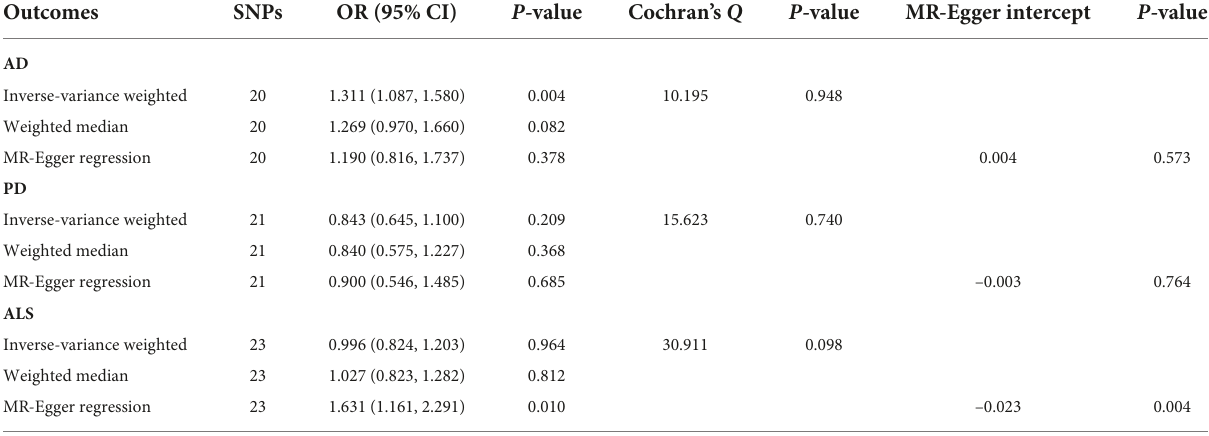
TABLE 2 Mendelian randomization analyses of circulating glutamate levels on three neurodegenerative diseases.